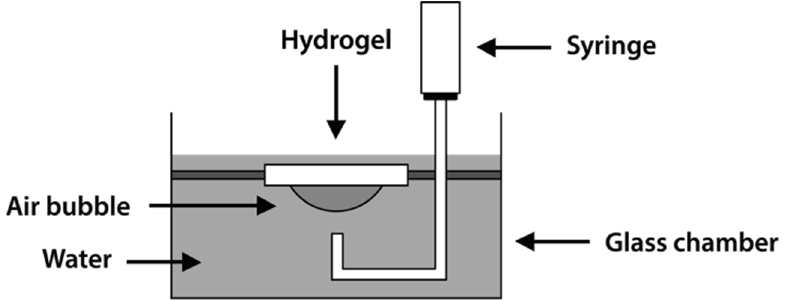
Figure 2. Schematic diagram of the apparatus for contact angle measurements of air on hydrogels by the captive bubble technique.